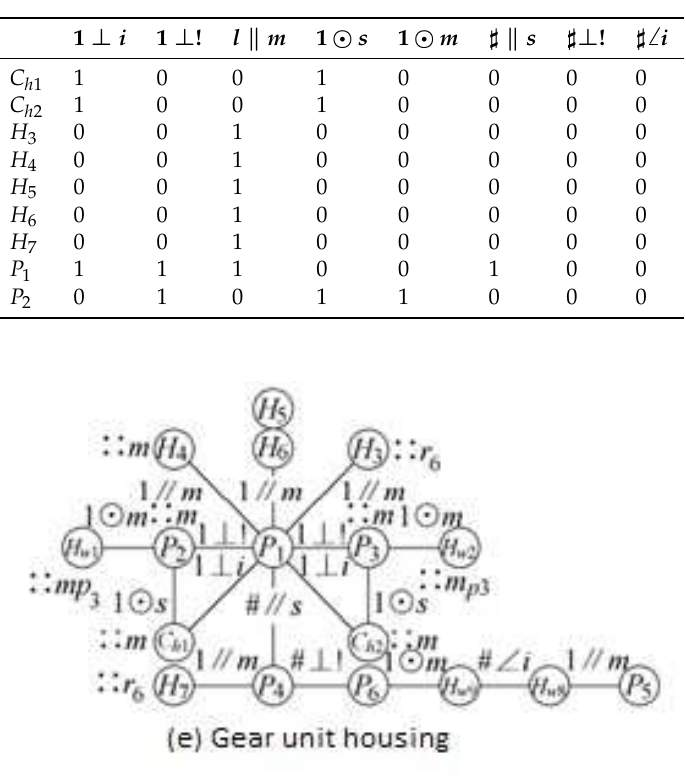
Figure 6. Figure 3’s 3D structure